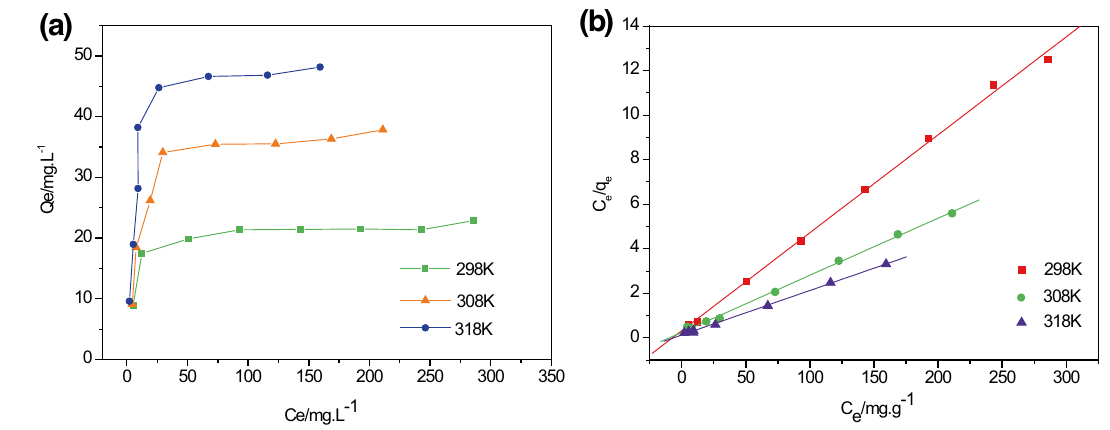
Figure 5. Adsorption isotherms NiO/sepiolite ( a ), isothermal adsorption of NiO/sepiolite: filled circles represent experimental data and the line represents the simulated Langmuir model ( b ).